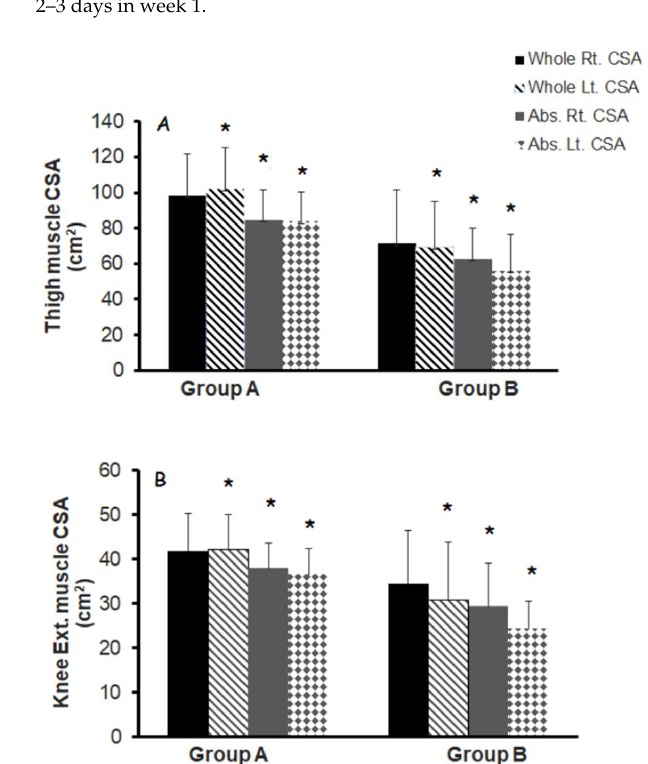
Figure 1. Whole thigh and knee extensor muscle CSAs with different musculoskeletal qualities in groups ( A , B ) classified based on NMES amplitude (greater or less than 100 mA) and leg extension repetitions (greater or less than 70 reps per week) in persons with chronic SCI. * denotes statistical significance between groups.